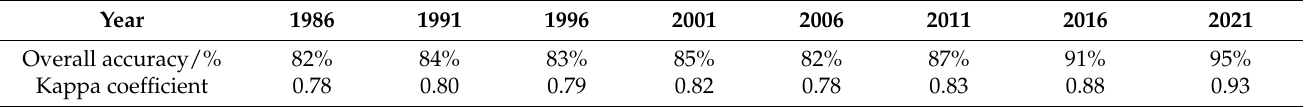
Table 2. Accuracy of land use classification obtained based on the phenological index.